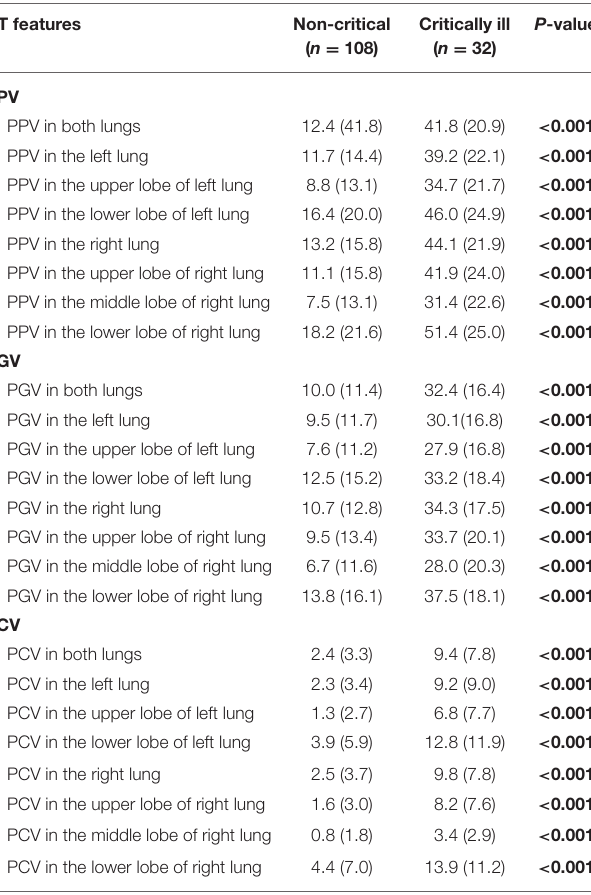
TABLE 2 | Comparison of clinical and laboratory variables between the non-critical and critical groups. Characteristics